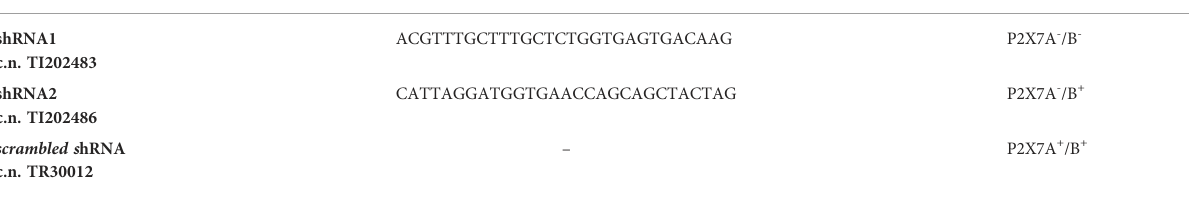
TABLE 1 Target sequences of shRNAs used for ACN cell